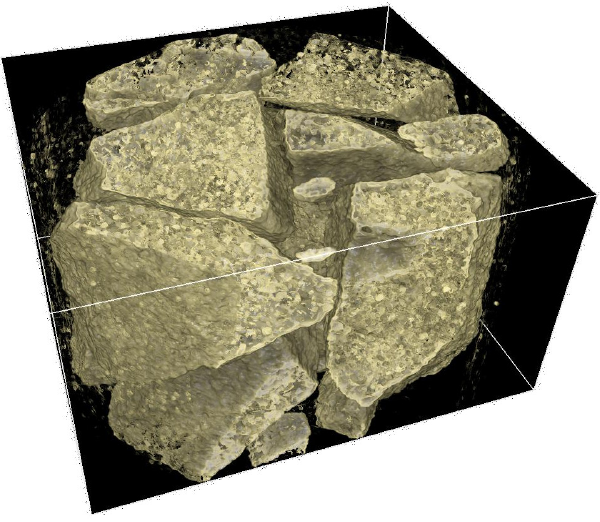
Figure 7. Rendered volume of the stationary “dry” sample (sand- stone) prior to water ingress. Reconstruction from 150 projections using a CGLS–TV